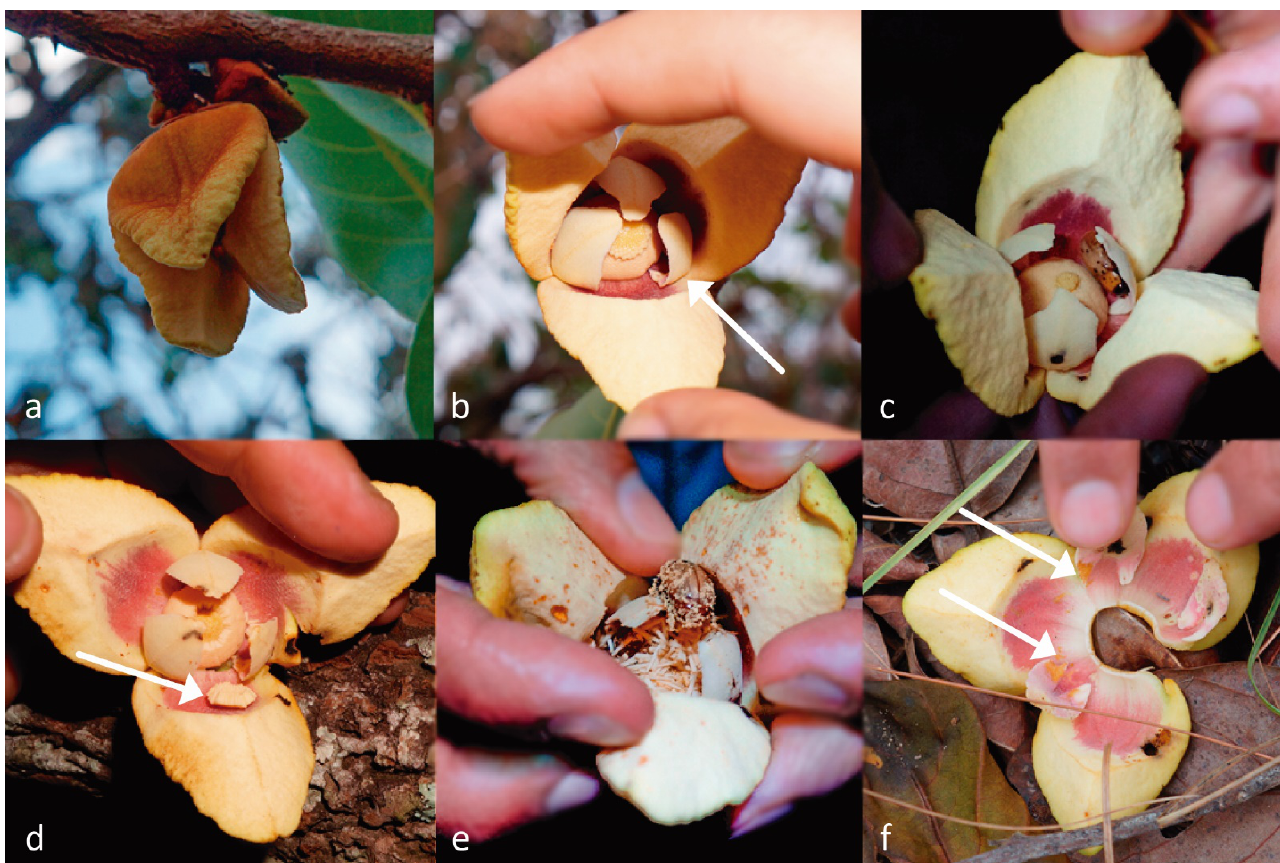
Figure 3. Stages of anthesis of Annona crassiflora . ( a ) The fruit-like flower has outer petals with a yellow and ferruginous-tomentose abaxial surface. Anthesis begins during the early evening hours. ( b ) The female phase is marked by the production of stigmatic exudate by the gynoecium (arrow). Here, the thicker outer petals and the smaller and thinner inner petals are shown. ( c ) A Cyclocephala quatuordecimpunctata individual feeding on the basal lobe of an inner petal during the female phase. ( d ) Before entering the male phase, the gynoecium detaches from the receptacle (arrow). Note the purple to reddish basal patch on the inner petals. ( e ) Cyclocephala celata visiting a male-phase flower, with its anthers detached and dehisced. ( f ) The shed corolla from a flower on the day after anthesis showing herbivory marks (arrows) of Cyclocephala spp. At the spot where the basal lobes are located (data from authors own studies).